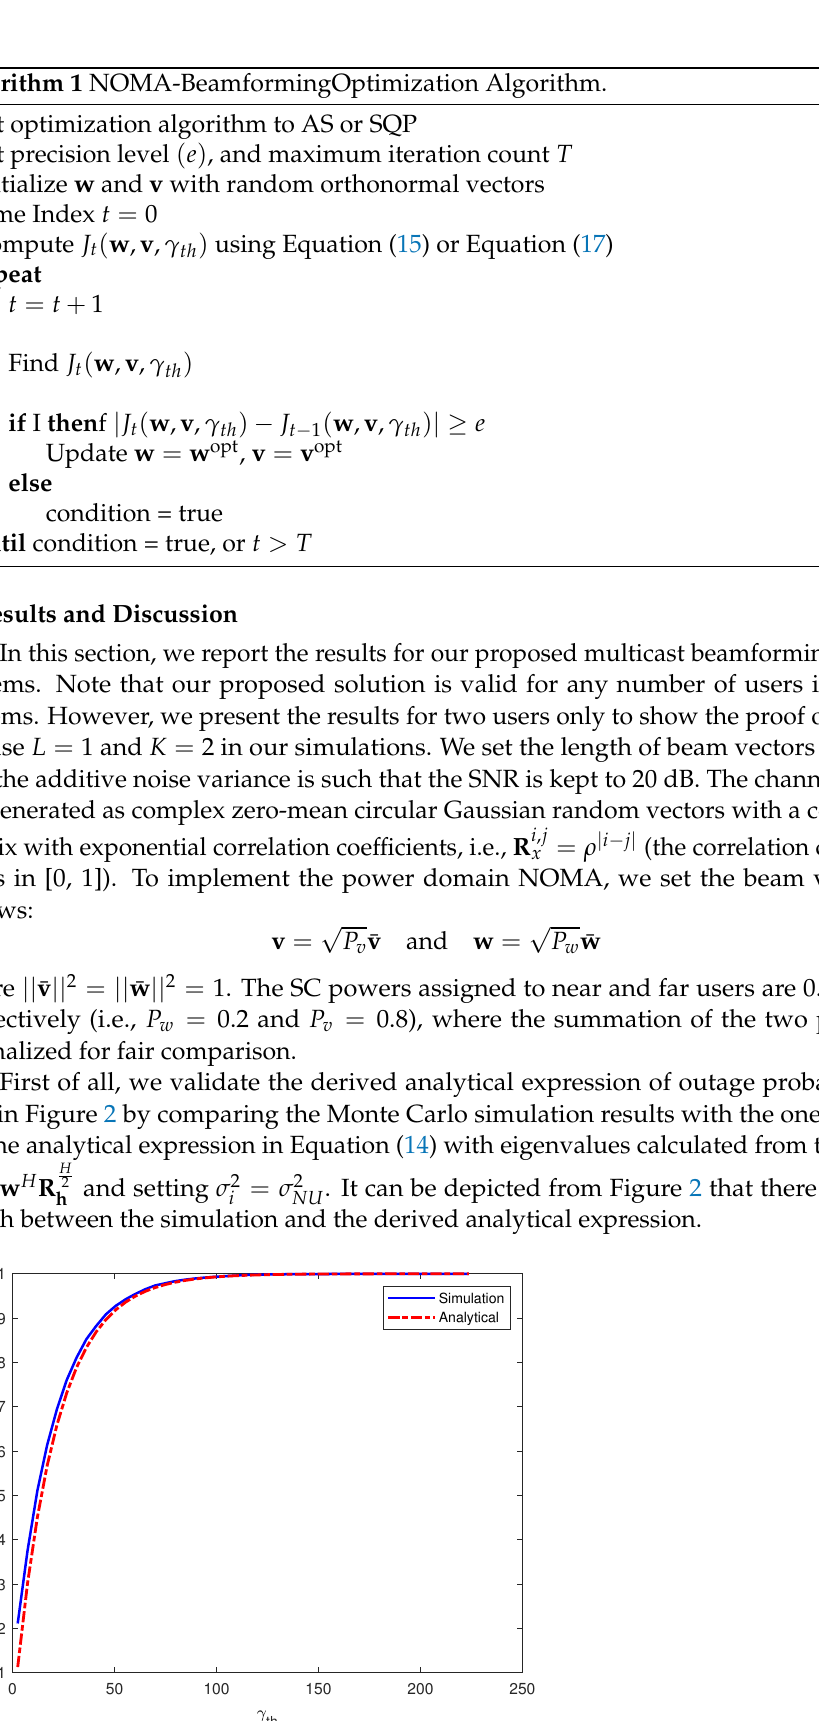
Figure 2. Validation of analytical outage probability P out , ζ